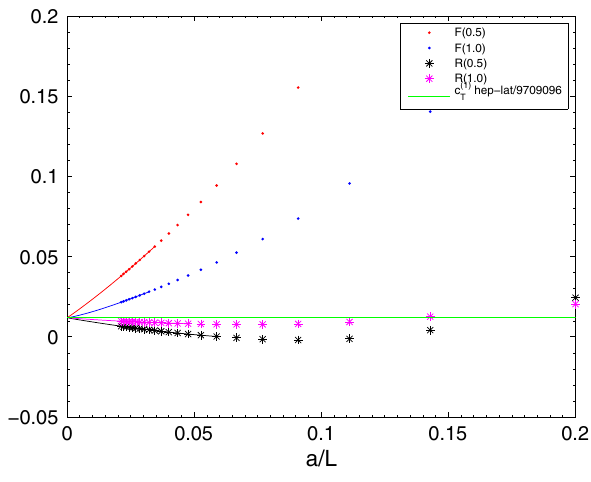
Fig. 12 Extraction of c ( 1 )